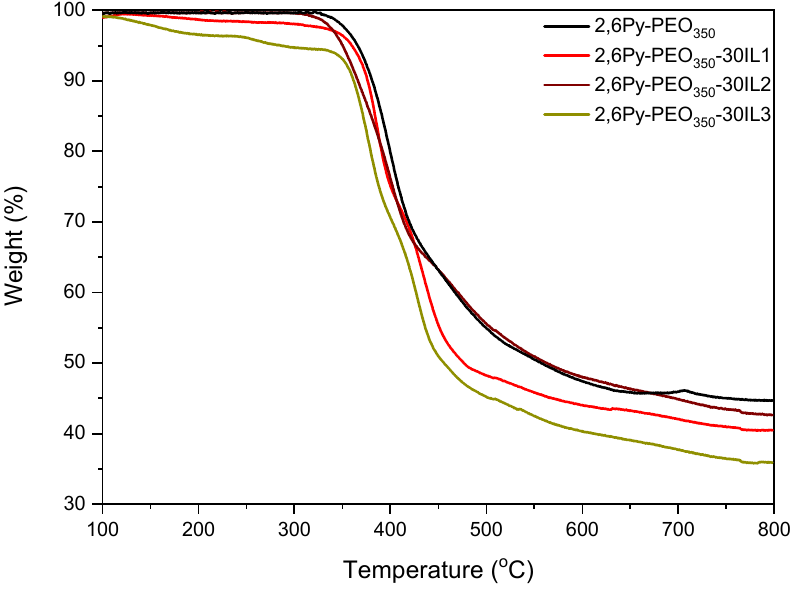
Figure 3. Comparative TGA curves of precursor-PEO 350 and polymer composite membranes with 30 wt% IL.